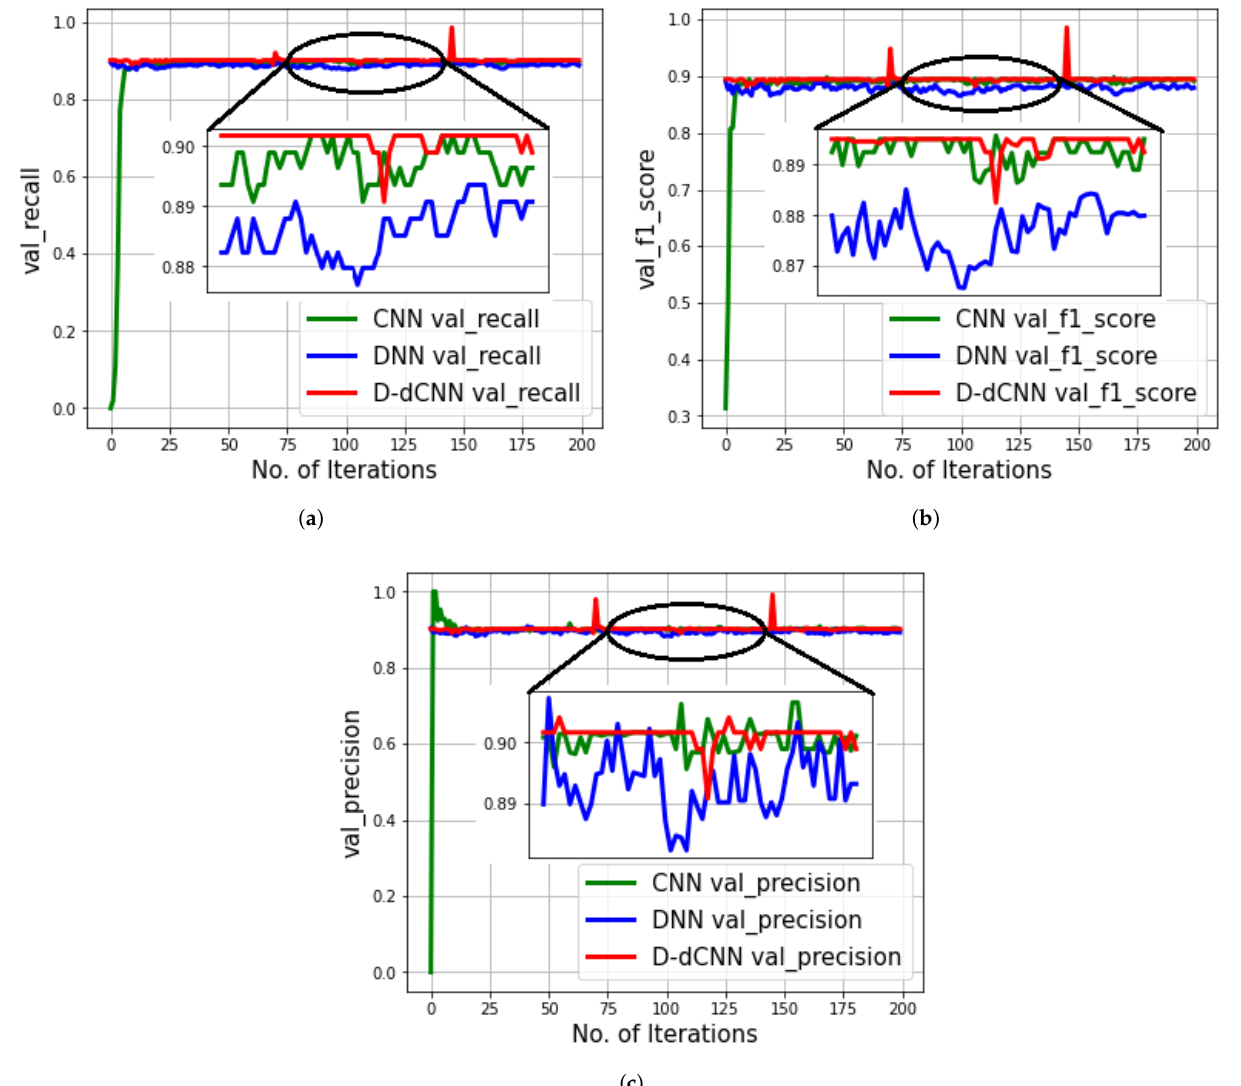
Figure 4. Test/validation progress of proposed model and standalone models over 200 iterations. ( a ) Recall ( b ) F1-score, and ( c )